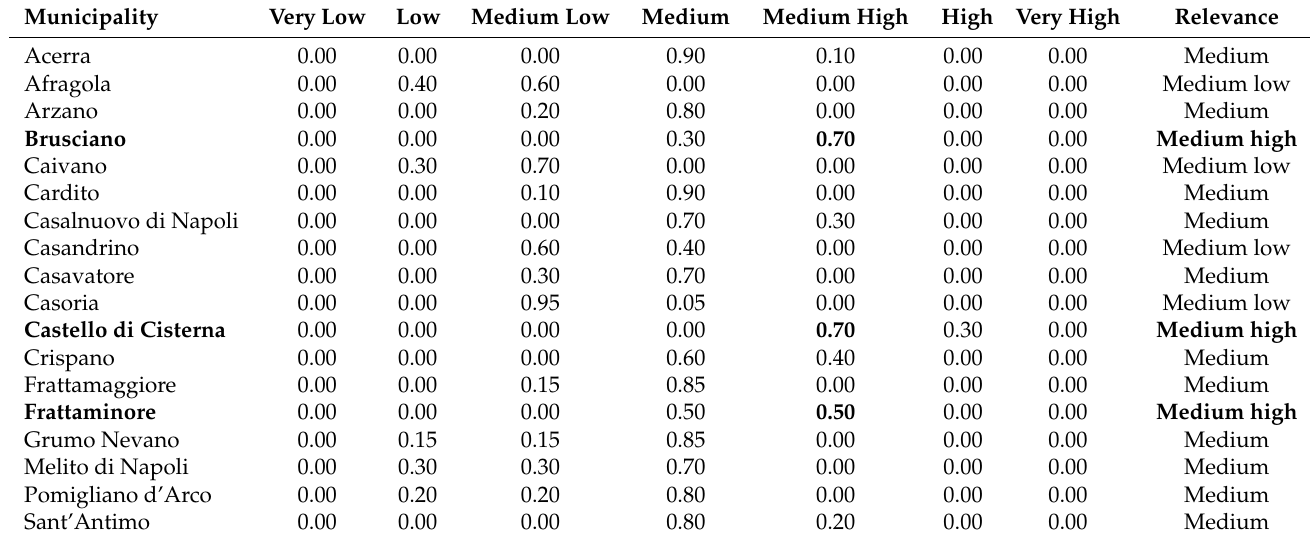
Table 2. Relevance of pleasant emotional categories in the year 2020.